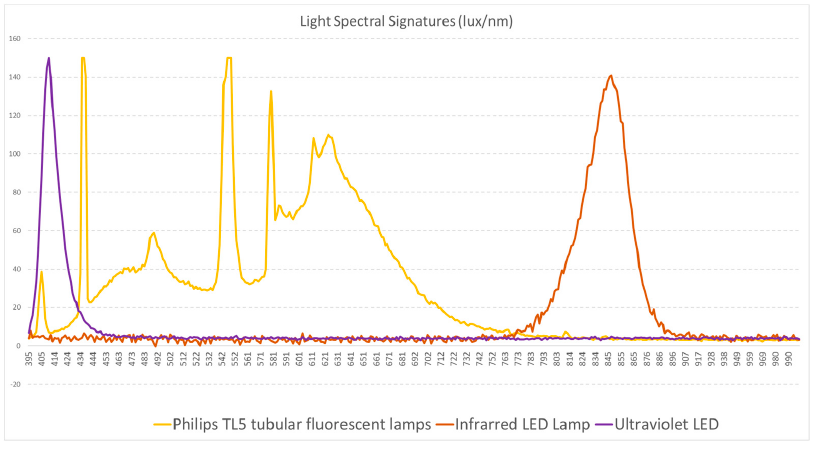
Figure 6. Spectral signatures of the lamps. Horizontal axis represents the wavelength in nanometers and the vertical axis represents the relative spectral power [ 4] . and the vertical axis represents the relative spectral power